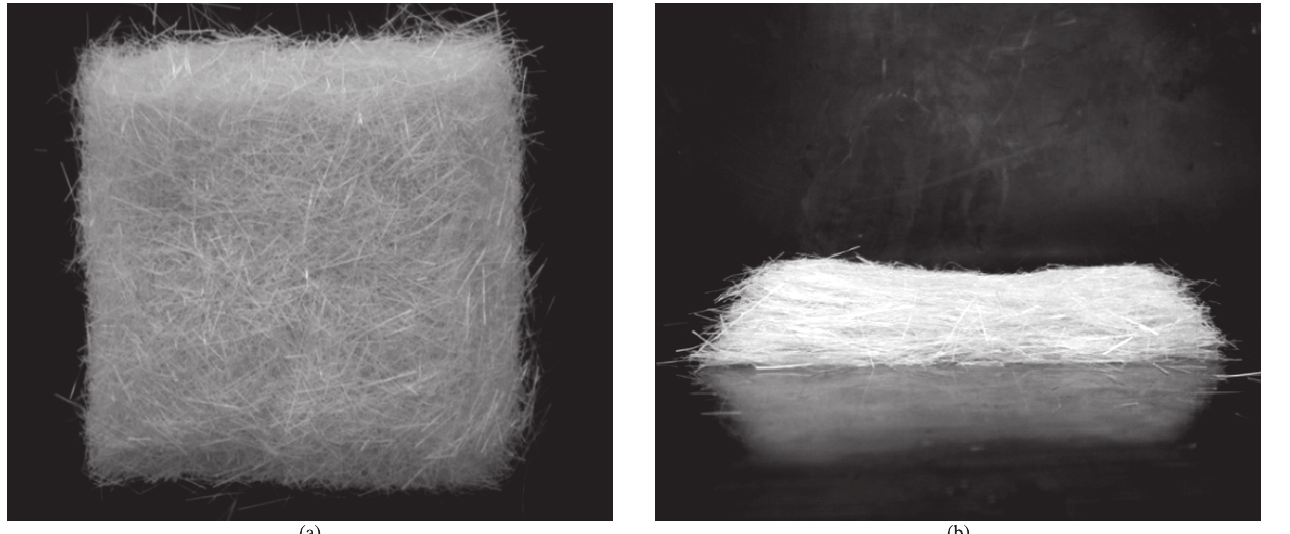
Figure 6. Hybrid mat (50% glass fiber / 50% sisal fiber) manufactured with the non-aqueous method: (a) superior view and (b) side